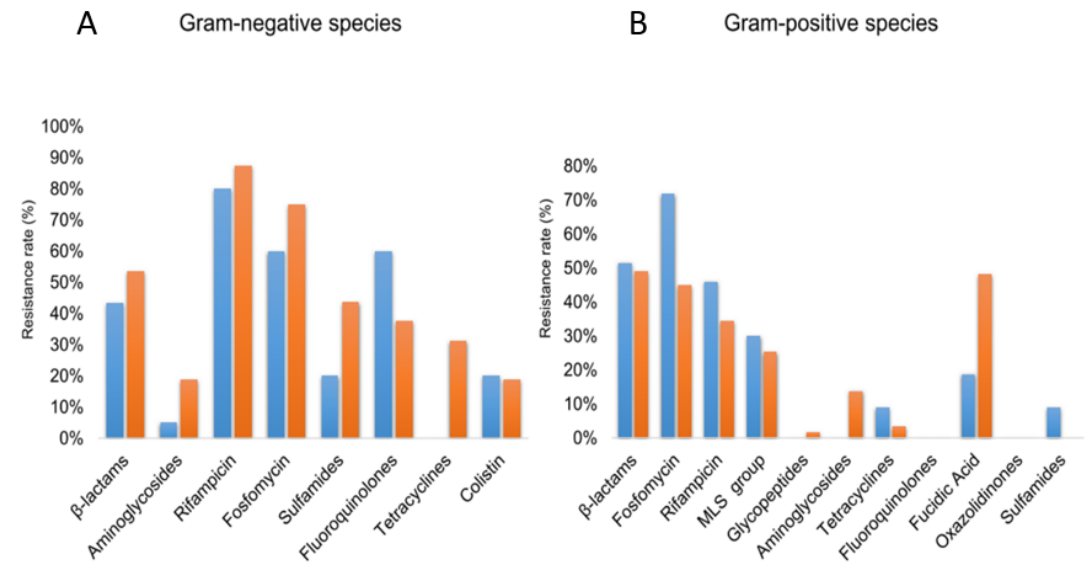
Figure 2. Antibiotic resistance rates among permafrost and modern strains. Only species for which both permafrost and modern strains were available for antibiotic susceptibility testing were included. ( A ) represents results from 10 gram-negative species (including 10 permafrost strains and 16 modern strains. ( B ) represents the results from 11 gram-positive bacterial species (11 permafrost strains and 29 modern strains).